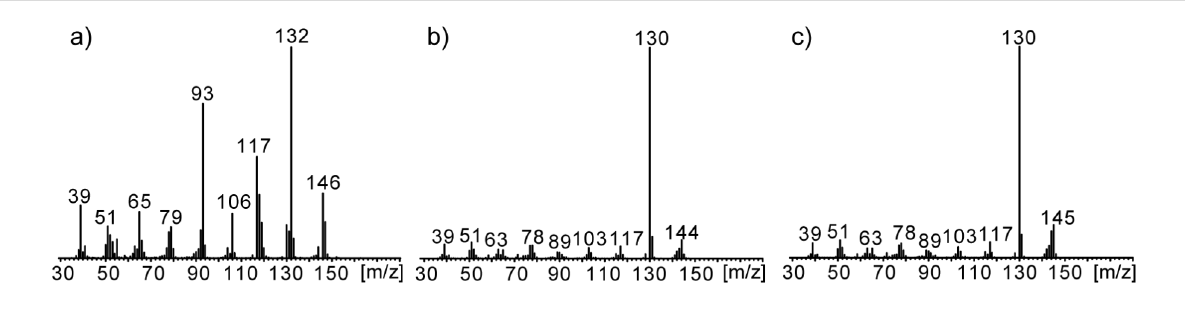
Figure 3: Mass spectra of a) ( E )-2-(pent-3-en-1-yl)pyridine (streptopyridine E, 8 ), b) (1 Z ,3 E )-penta-1,3-dien-1-yl)pyridine (streptopyridine A, 9 ), c) 2-((1 E ,3 E )-penta-1,3-dien-1-yl)pyridine (streptopyridine B, 12 ).